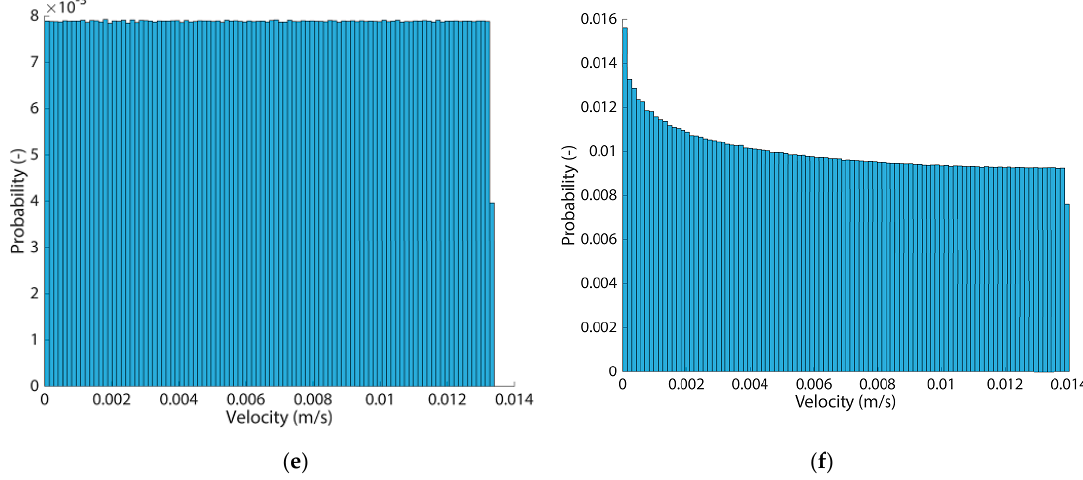
Figure A6. Comparison between circular and square cross-sectional channel with identical cross-sectional areas for velocity and shear stress: ( a ) Velocity field inside a circular cross-sectional channel showing an axial symmetry; ( b ) Velocity field inside a square cross-sectional channel, showing stagnation of the flow in the corners; ( c ) Shear stress profile inside a circular cross-sectional channel. The shear stress is constant along the wall and independent of position; ( d ) Shear stress profile inside a square cross-sectional channel. The shear stress shows a flattened parabolic profile along the walls with vanishing shear stress in the corners; ( e ) Probability density function of velocities inside a circular cross-sectional channel, showing a uniform distribution; ( f ) Probability density function of velocities inside a square cross-sectional channel: the distribution shows an increase for the lower velocities because of the corners.